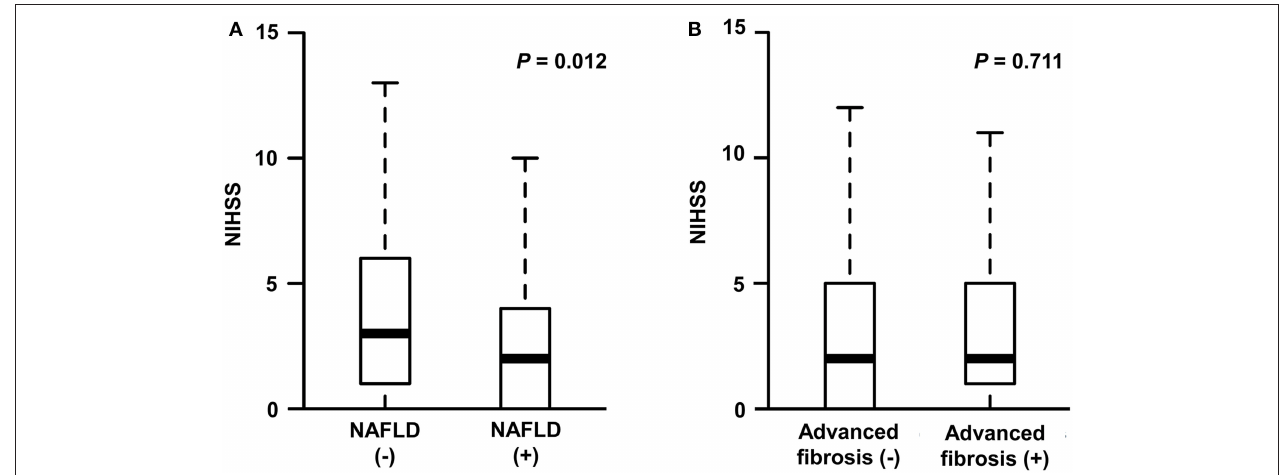
FIGURE 2 | Stroke severity according to the presence of NAFLD (A) or advanced fibrosis (B) . NIHSS, National Institute of Health Stroke Scale; NAFLD, non-alcoholic fatty liver disease.